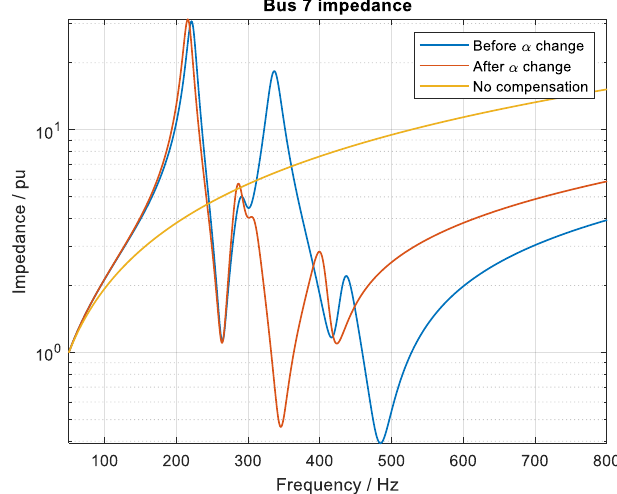
Figure 14. The 7th harmonic frequency parallel resonance mitigation in bus 7.